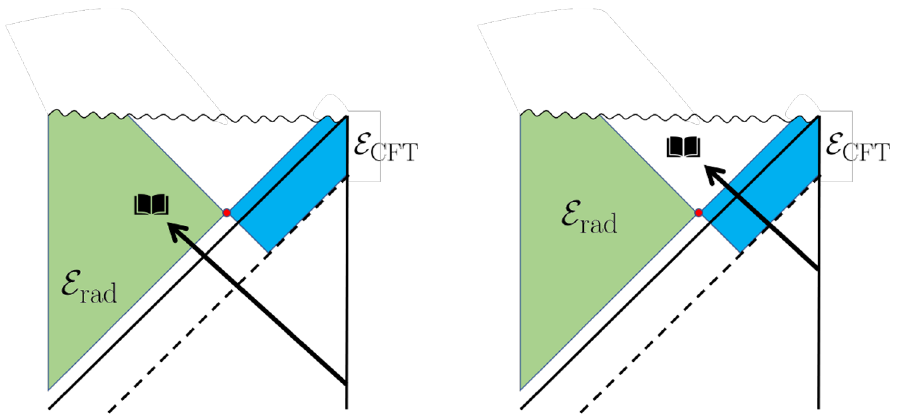
Figure 6. If a diary was thrown into the black hole more than the scrambling time into the past (left), it will now lie in the entanglement wedge of the reservoir H rad and can in principle be decoded using only the Hawking radiation. A diary thrown into the black hole more recently (right) remains in the entanglement wedge of, and encoded in, the